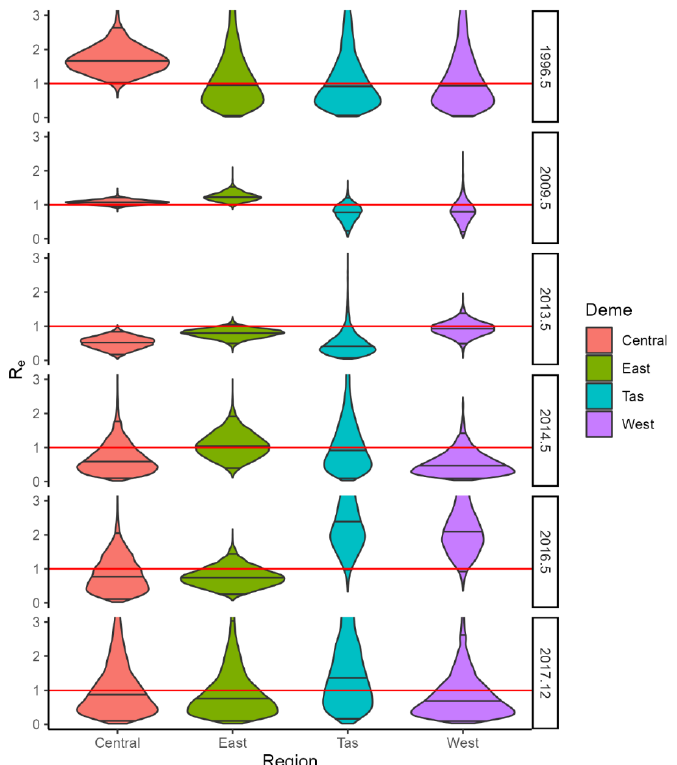
Figure 9. Violin plots of R e densities for RHDV1 in each region (Central, Eastern, Western, and Tasmania) and epoch. Red line marks R e = 1.